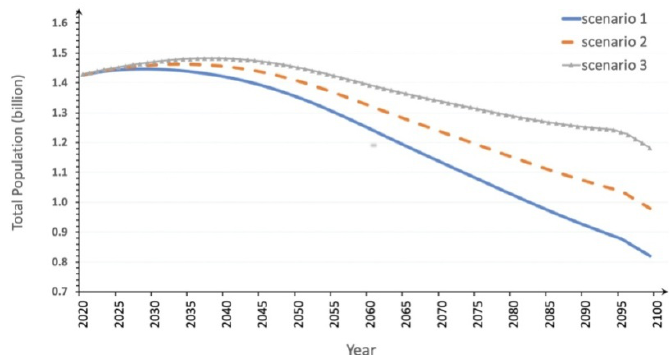
Figure 2. China’s future population until 2100 under different total fertility rate (TFR)scenarios .